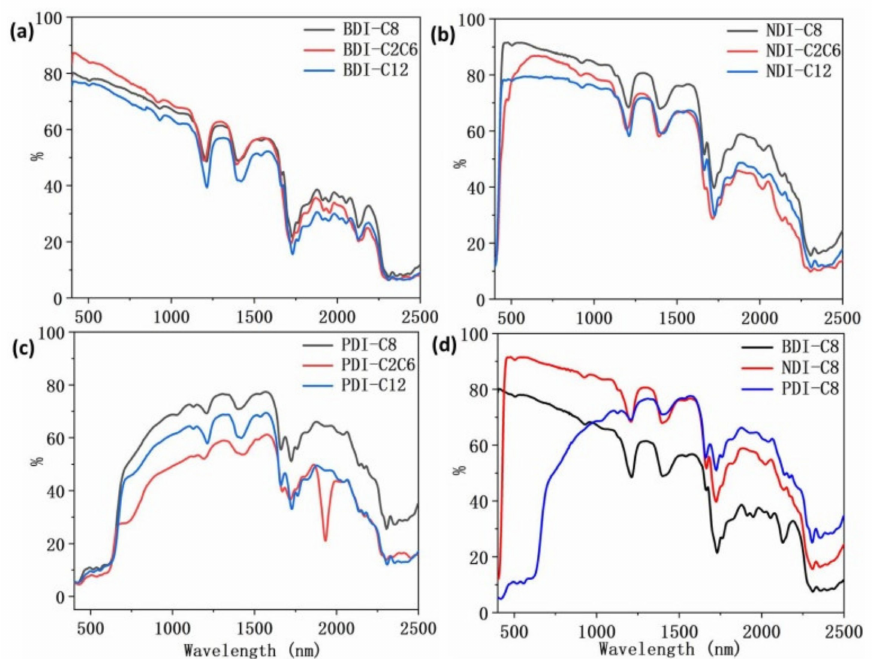
Figure 4. NIR reflectance spectra of: ( a ) BDI-, ( b ) NDI-, ( c ) PDI-based compounds with different alkyl groups, and ( d ) BDI, NDI and PDI with C8 alkyl